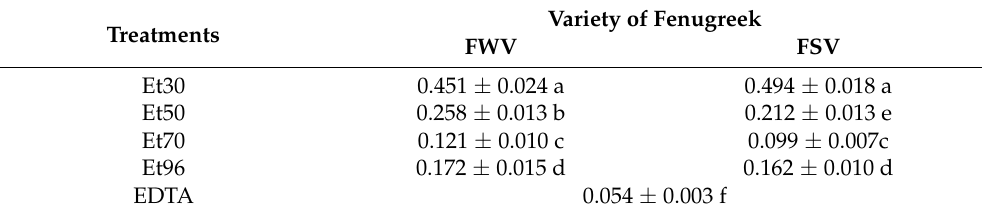
Values shown are means ± standard error. Values within columns and between the extracts of the two varieties bearing same letter are not significantly different ( p < 0.05). Treatments: Et30 = extract with 30%